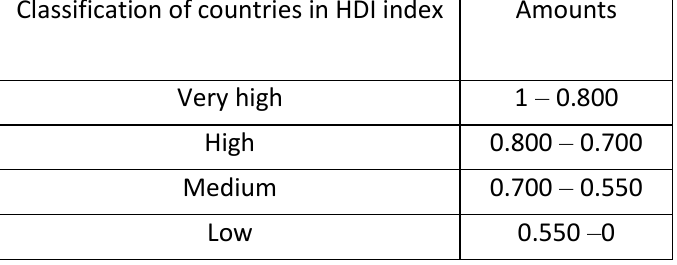
Table 1: Iran's ranking in human development indicators